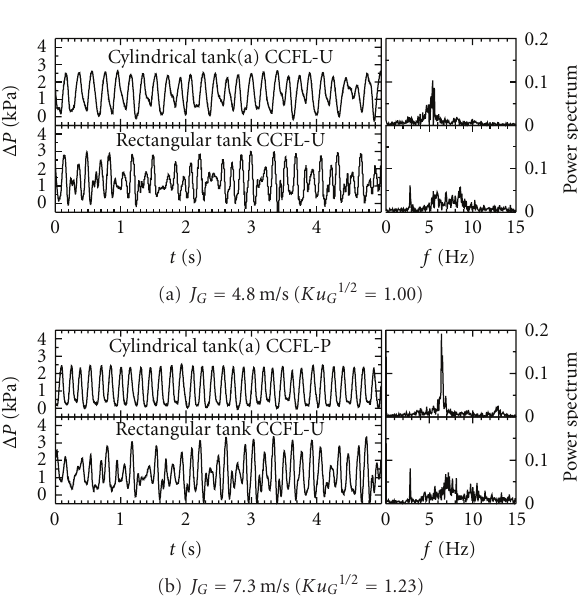
Figure 6: Pressure di ff erence Δ P between upper and lower tanks ( D = 45